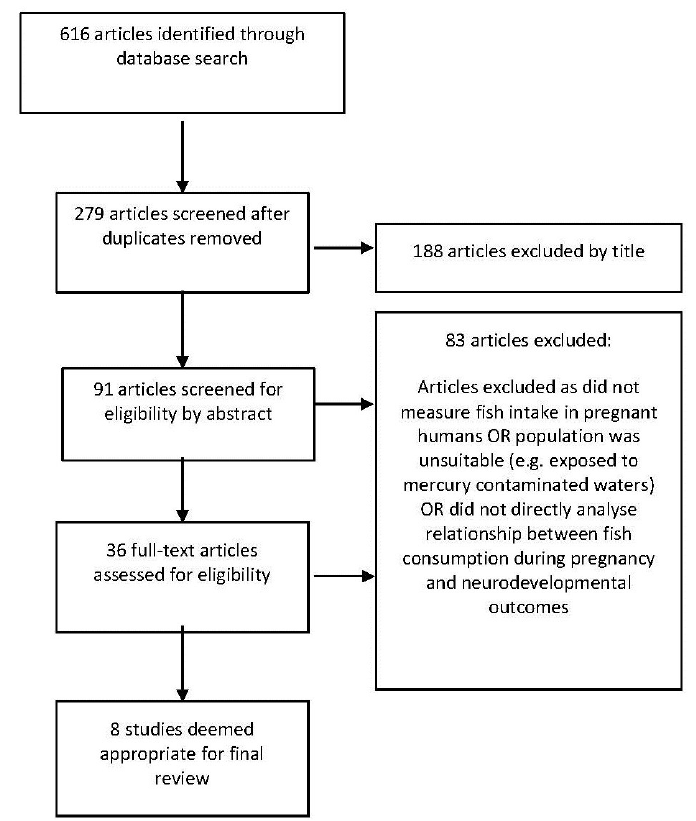
Figure 1. Flow diagram for inclusion of journal articles